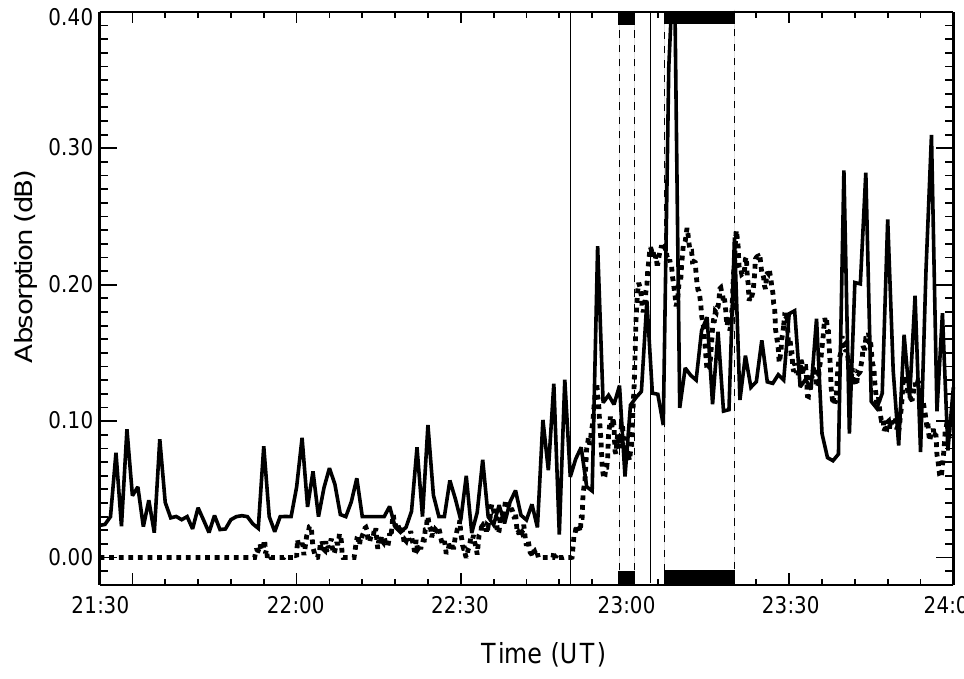
Fig. 5. Measured (dashed line) and modelled (solid line) IRIS beam 2 absorption, between 21:30 and 24:00UT. See text for details. Pi2 onset times are marked with vertical solid lines and the intervals of HF radar data loss with vertical dashed lines, as in Fig. 2.